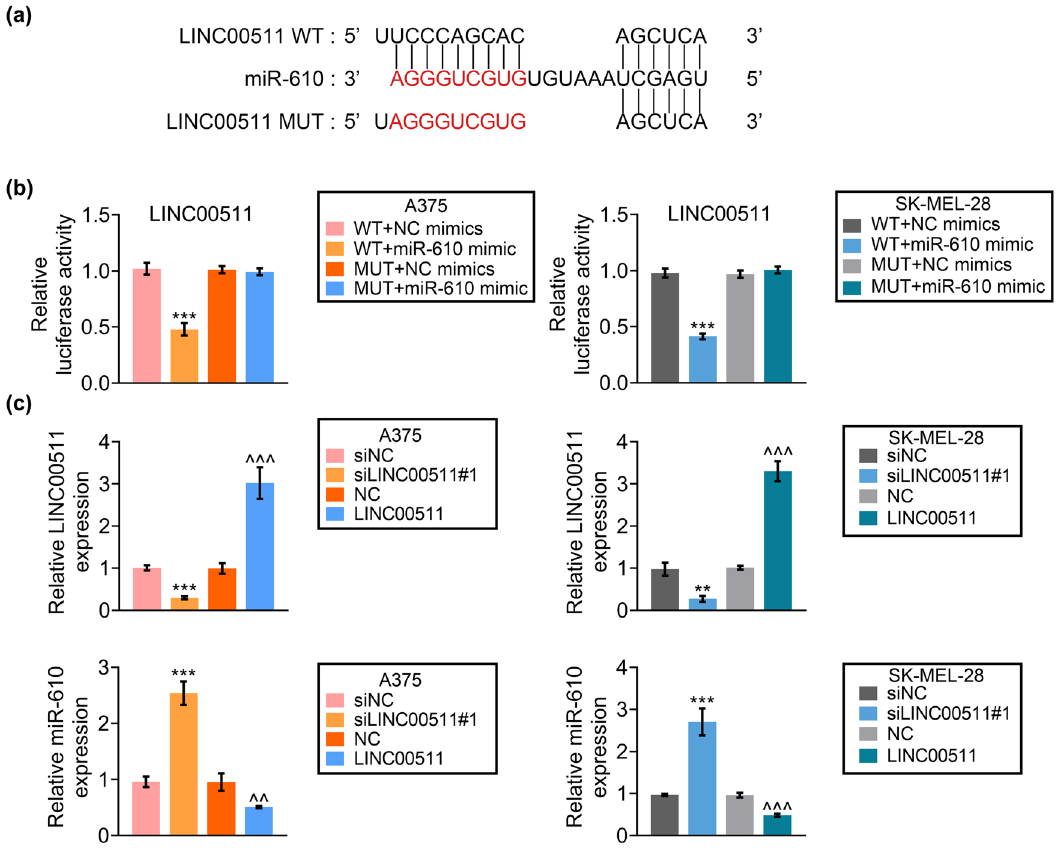
Figure 3: LINC00511 binds to miR - 610. ( a ) Potential binding site between LINC00511 and miR - 610 was predicted using BiBiServ. ( b ) Transfection with miR - 610 mimics decreased luciferase activity of pmirGLO - WT - LINC00511 in A375 and SK - MEL - 28. ( c ) Silence of LINC00511 decreased LINC00511 expression and increased miR - 610 expression, while over - expression of LINC00511 increased